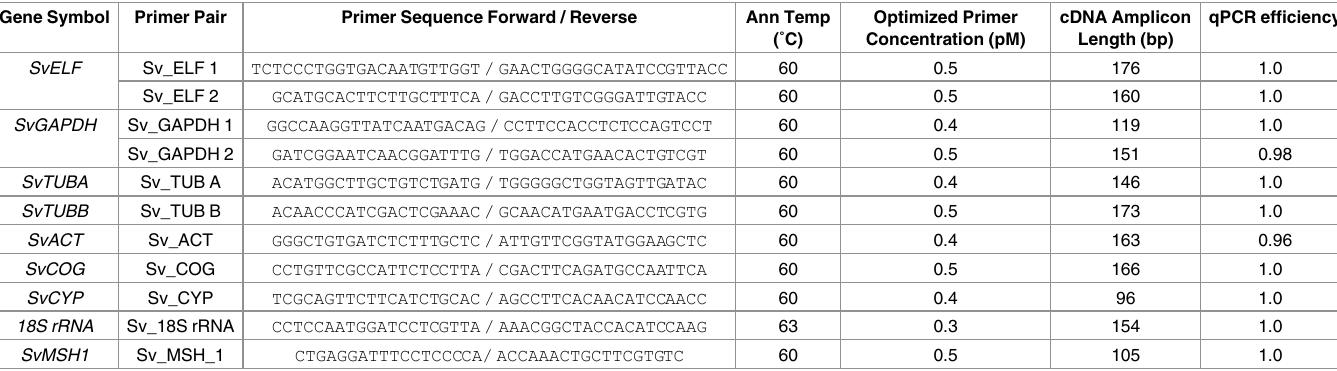
Cycling conditions: 5 min at 95˚C for initial denaturation followed by 50 cycles: 10 s at 95˚C, 10 s at 60˚C and 15 s at 72˚C, except for 18S rRNA primers where annealing was set to 10 s at 63˚C. The PCR efficiency for each assay was calculated with LightCycler 1 480 software from the calibration curve based on a serial dilution of cDNA (most often 20x, 40x, 80x, 160x, 320x). Specificity of qPCR in each sample was confirmed by melting curve analyses. The qPCR amplicons (Fig 1) were sequenced to confirm their identity. Table 2. Details of qPCR primers and